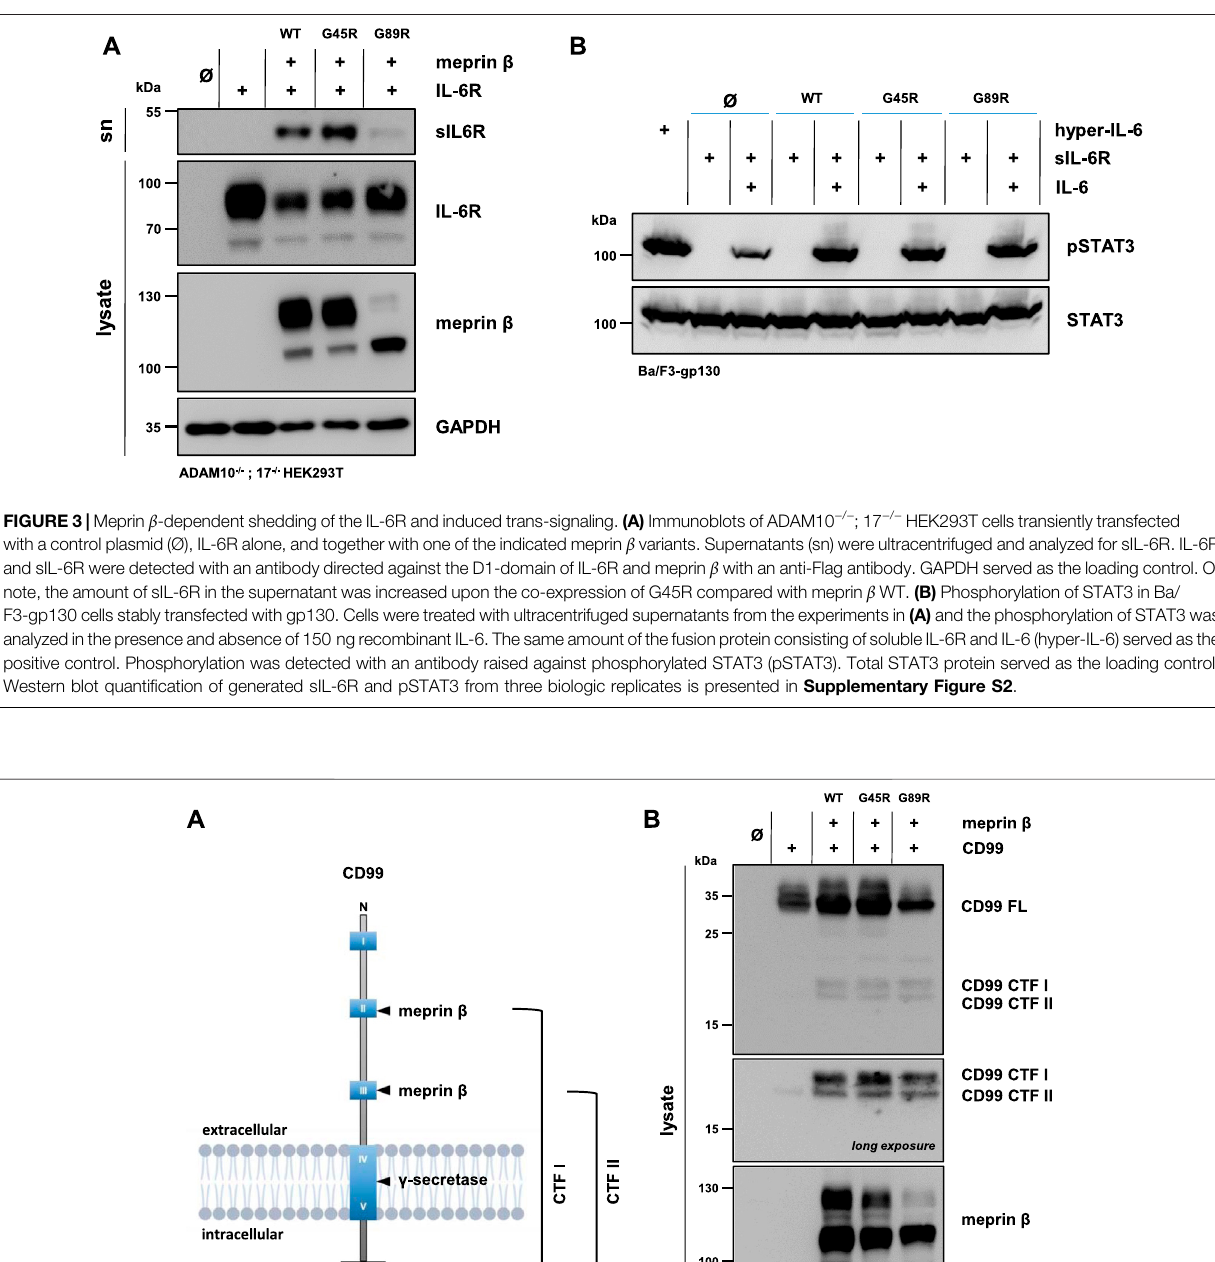
Frontiers in Molecular Biosciences |